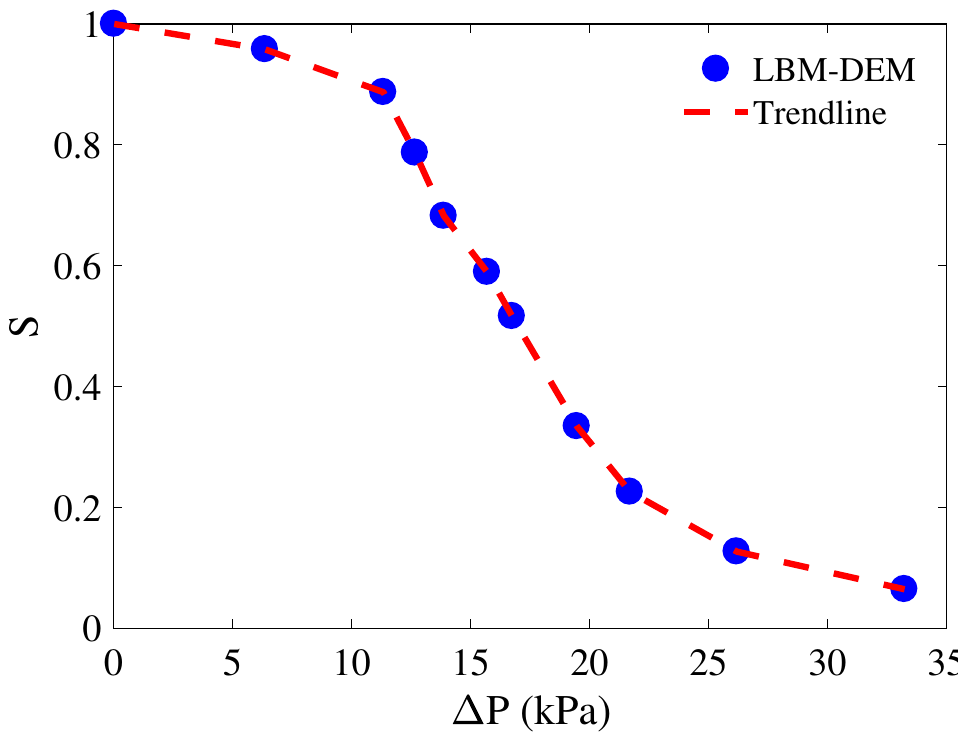
Figure 4. Degree of saturation vs. pressure difference between two phases for the analyzed